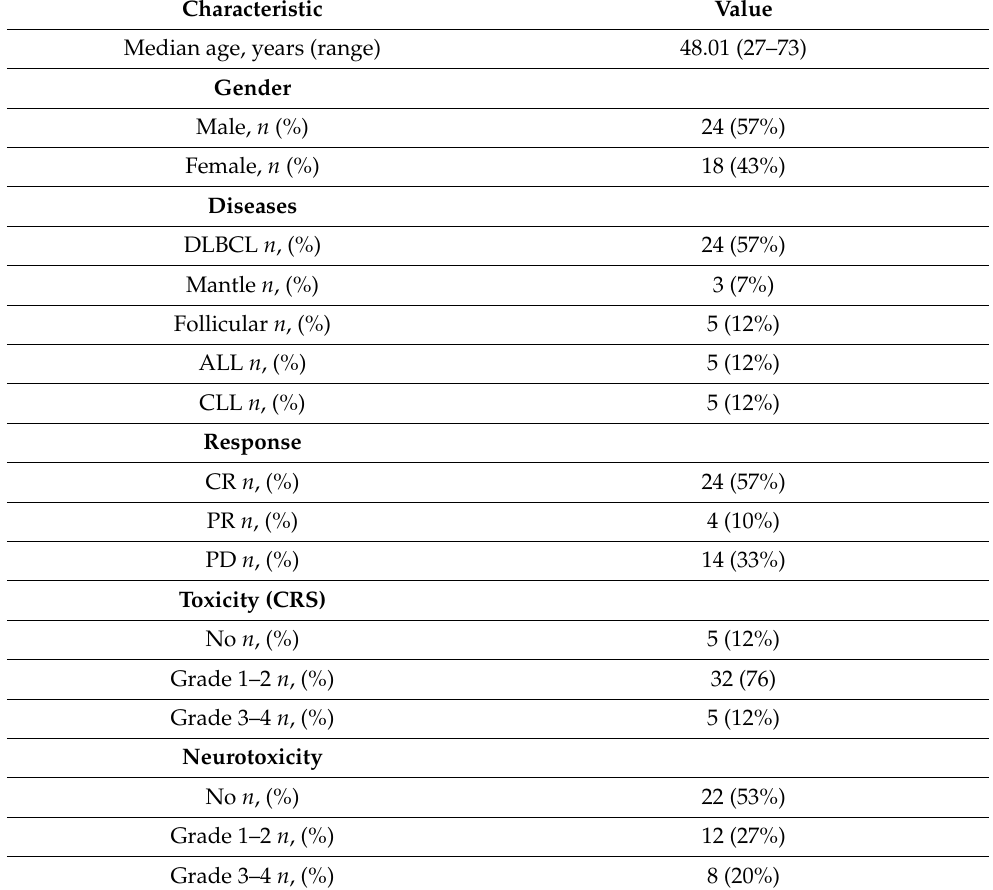
Table 1. Baseline characteristics of the patients treated with CD19 CAR T